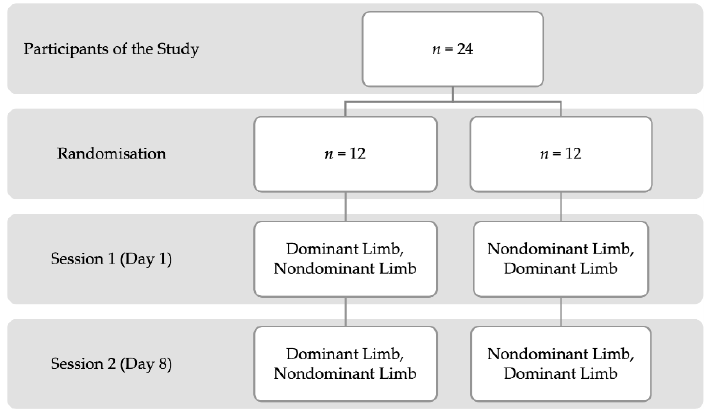
Figure 1. The study procedure.